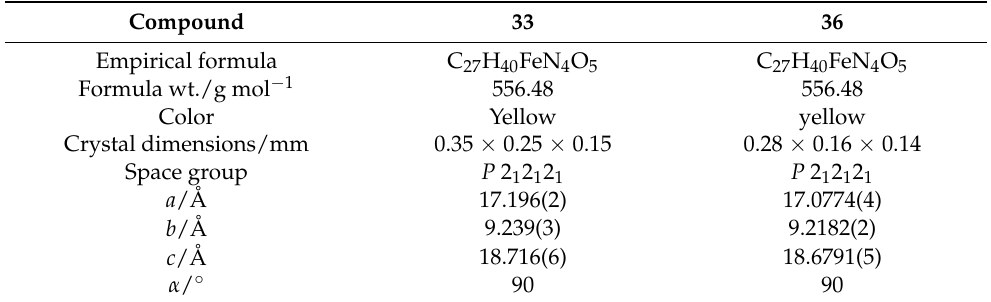
Table 4. Crystallographic, data collection and refinement data for variable-temperature X-ray